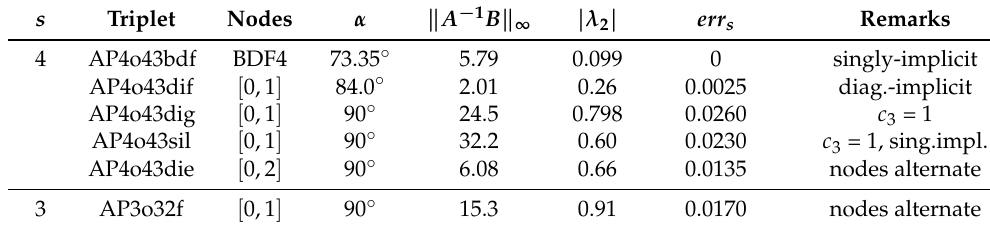
Table 3. Properties of the standard methods of Peer